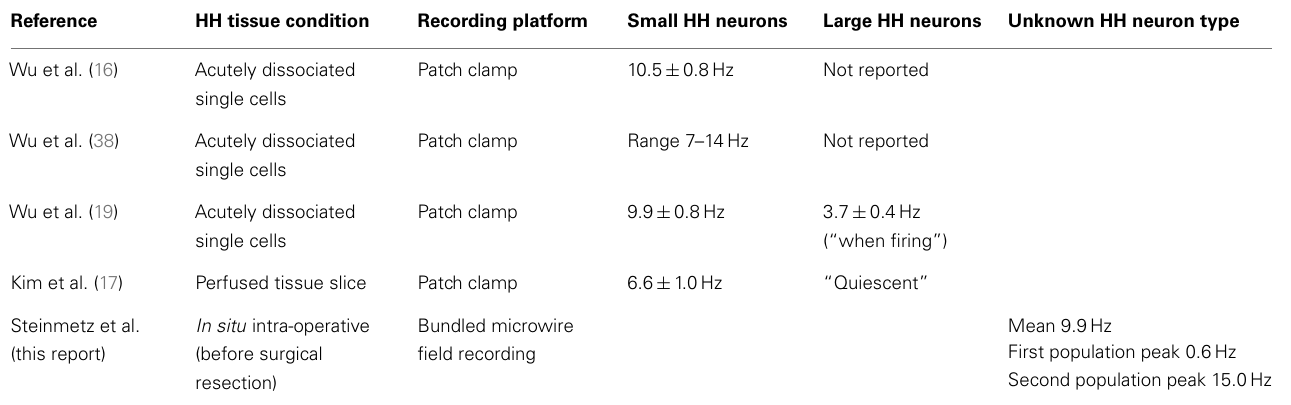
Table 3 | Firing behavior of human HH neurons under different recording